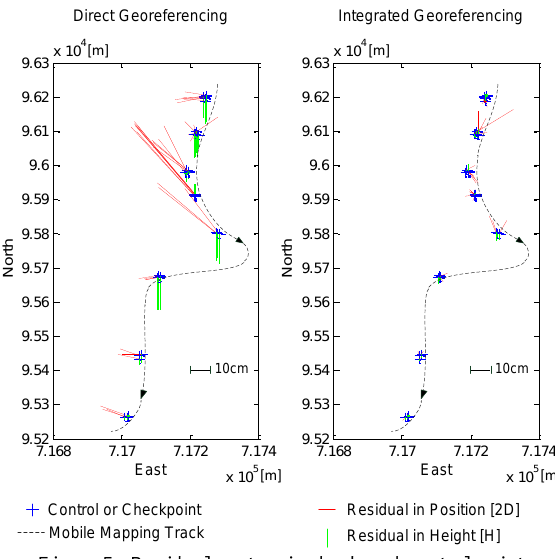
Figure 5. Residual vectors in check and control